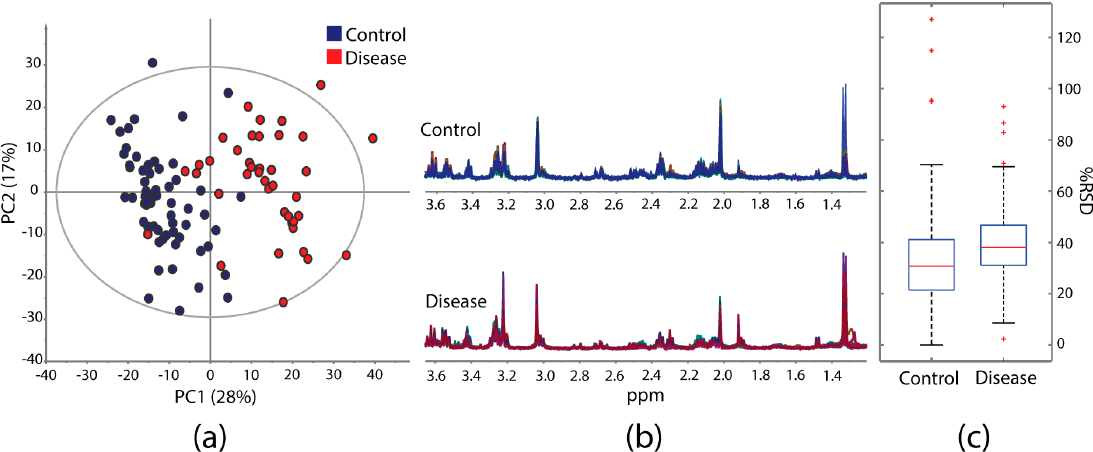
Figure 4. ( a ) PCA scores plot obtained from a model study containing 102 data on brain tissue (control and disease) from an initial 112 samples, where 10 (9%) were discarded due to either extra peaks from contamination or poor spectral quality from air pockets or dryness. Quality parameters: 14 components, R 2 X = 0.85, Q 2 = 0.63. ( b ) Overlaid 1 H-HR- μ MAS NMR spectra of (blue) 62 control and (red) 40 diseased tissue samples. ( c ) Boxplots of the relative standard deviation (%RSD) values calculated from the individual bucket intensity ( Δ = 0.04 ppm) of both groups across the spectral region (0.76–5.28 ppm). It summarizes the lower, median and upper quartiles, with the black whiskers displaying the range of data, and the red cross indicating the outlier data points.